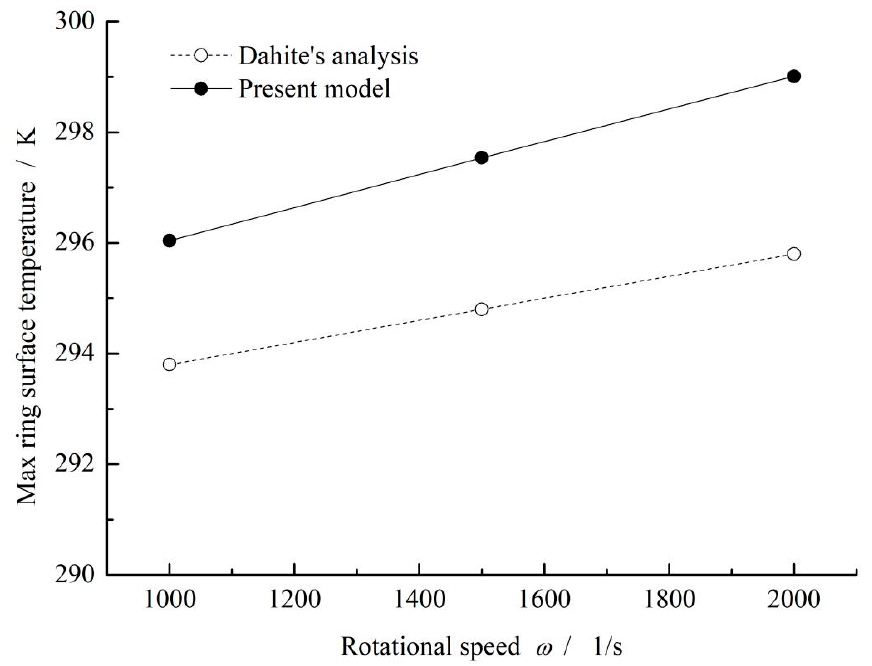
Figure 3. Influence of rotational speed on max ring surface temperature. ( p i = 0.1 MPa, p o = 0.6 MPa, ω = 1000 s − 1 , T in = 293 K, T out = 293 K).